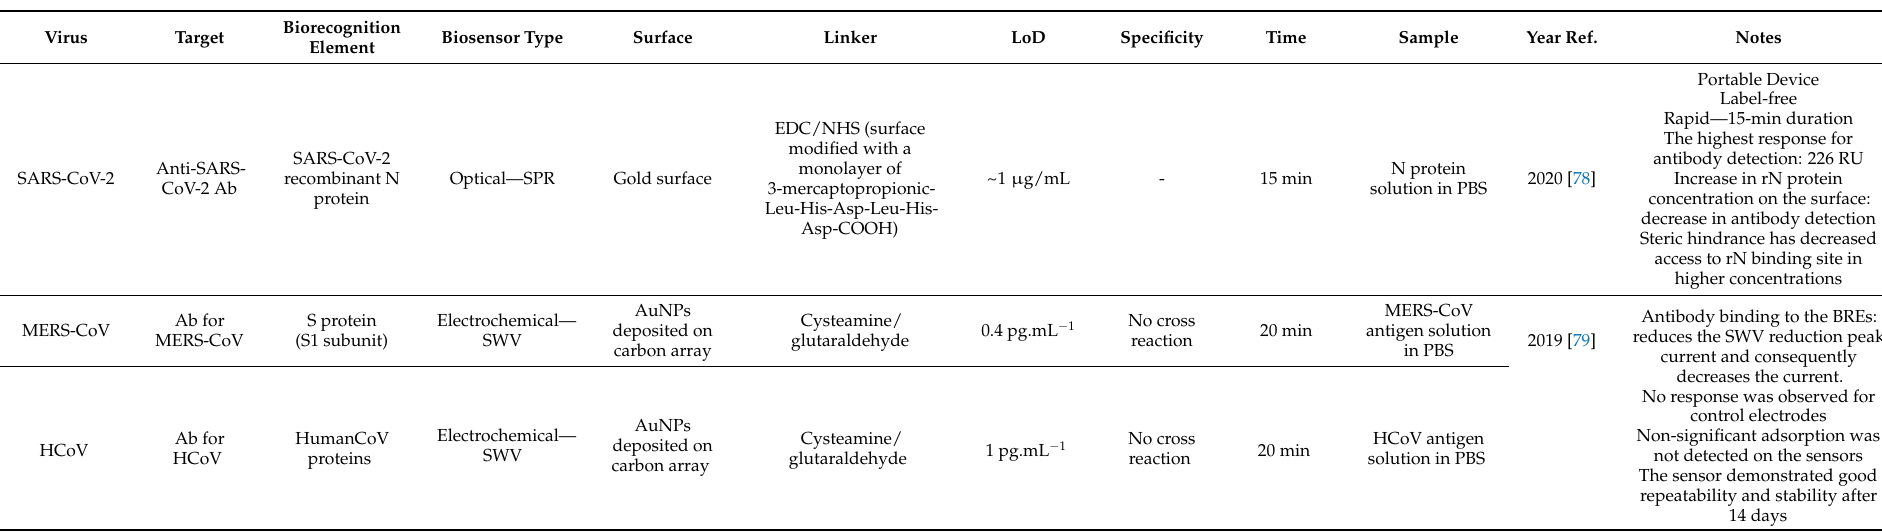
Table 3. The recent immunosensors functionalized with virus antigens for the detection of respiratory viral